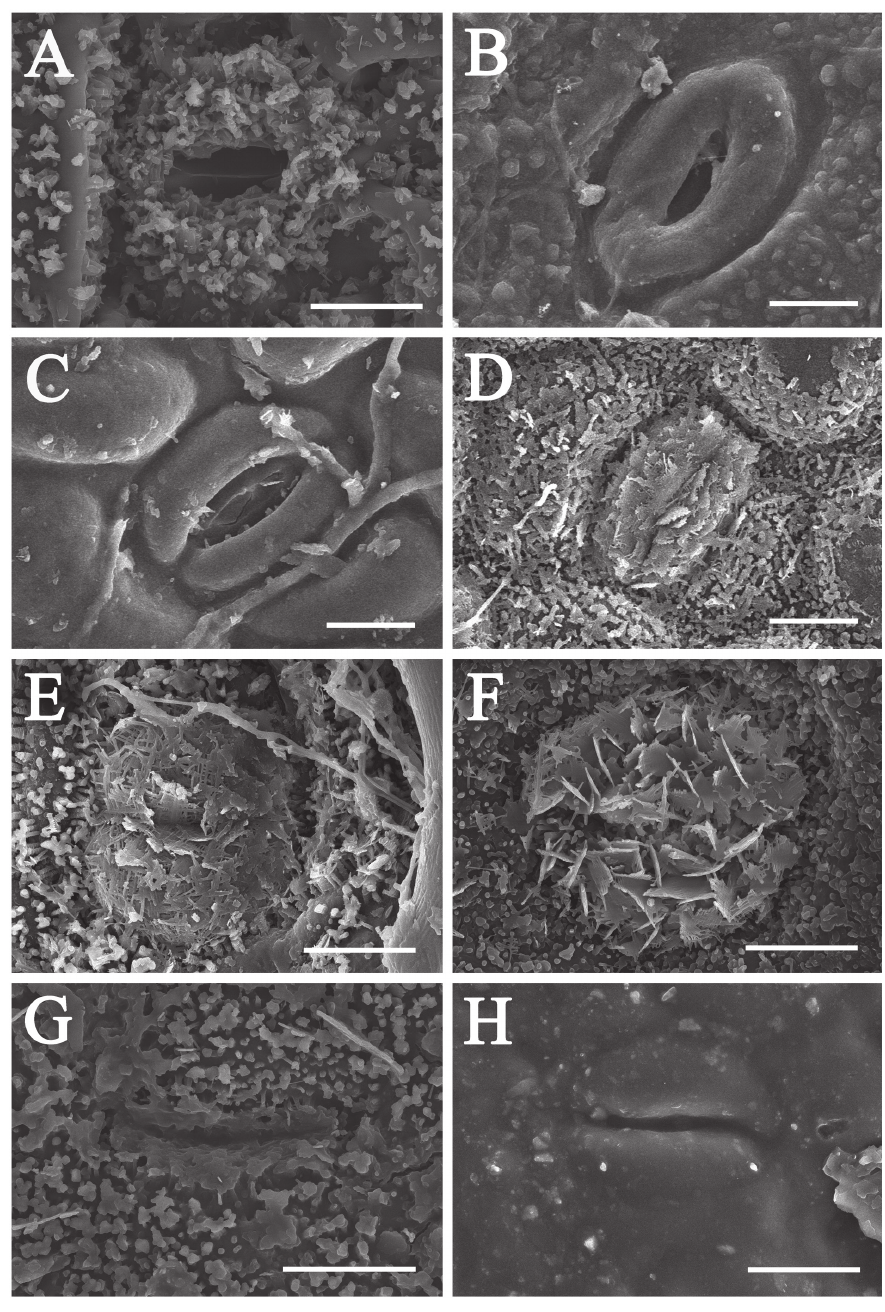
Figure 8. Lower leaf epidermis of Cinnamomum under scanning electron microscope displaying stomatal features A, B circular stomata A C. chartophyllum B C. micranthum C, D lip-shaped stomatal C C. migao D C. longepaniculatum E, F globose stomata E C. septentrionale F C. camphora G, H eyelid-shaped sto- mata G C. tonkinense H C. jensenianum . Scale bars: 10